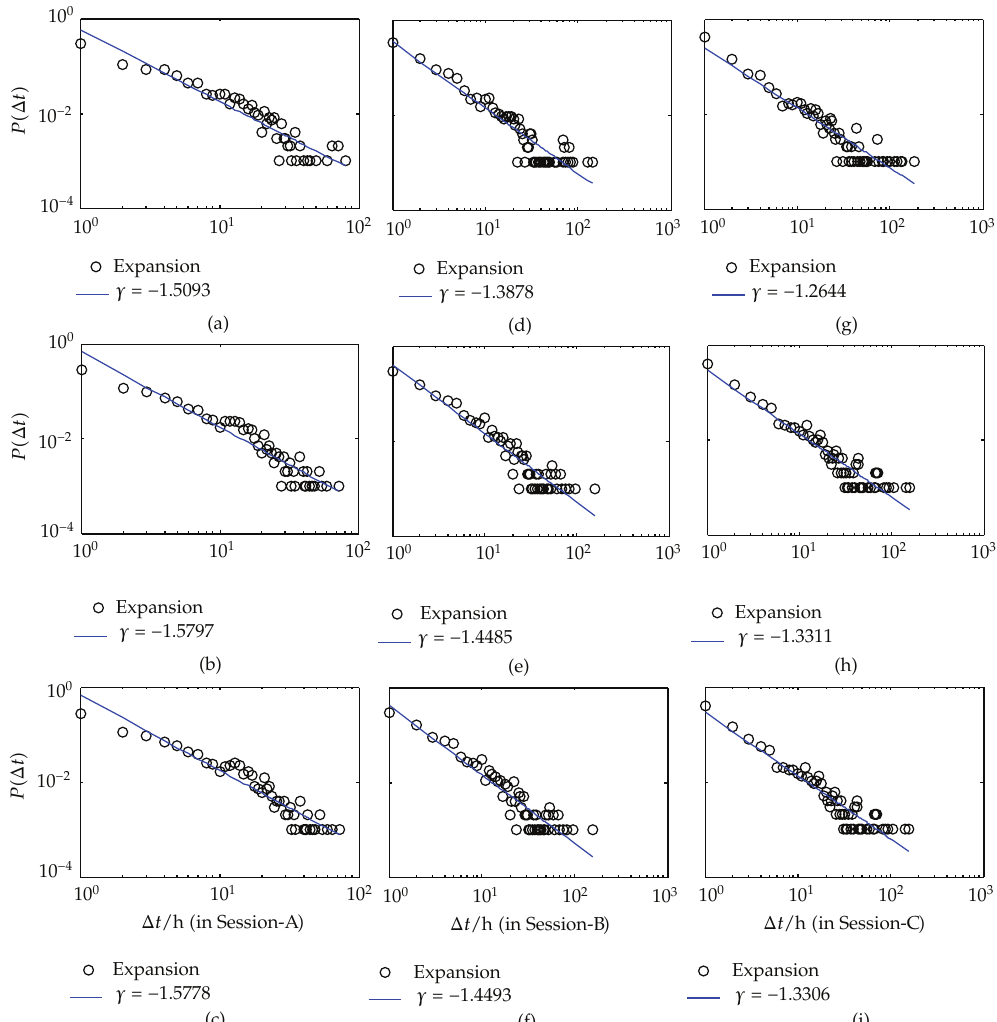
Figure 1: Interval distribution of endTime of hotspots. (cid:2) a (cid:3) – (cid:2) c (cid:3) show Session-A, (cid:2) a (cid:3) top 1000 posts sorted by reply number (cid:2) b (cid:3) top 1000 posts sorted by view number (cid:2) c (cid:3) top 1000 posts sorted by sum of reply